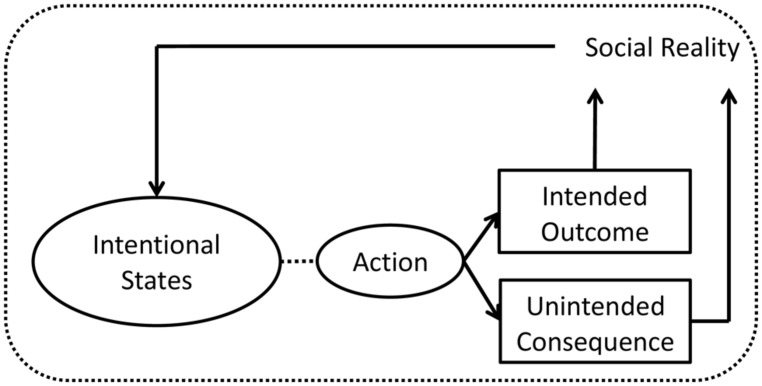
Model of action.